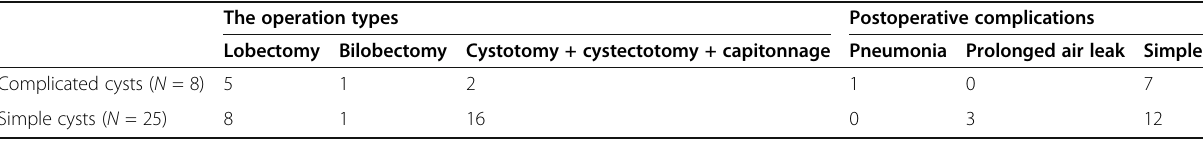
Table 4 Surgical procedure, complicated uncomplicated status of the cysts, and their correlations with postoperative complications The operation